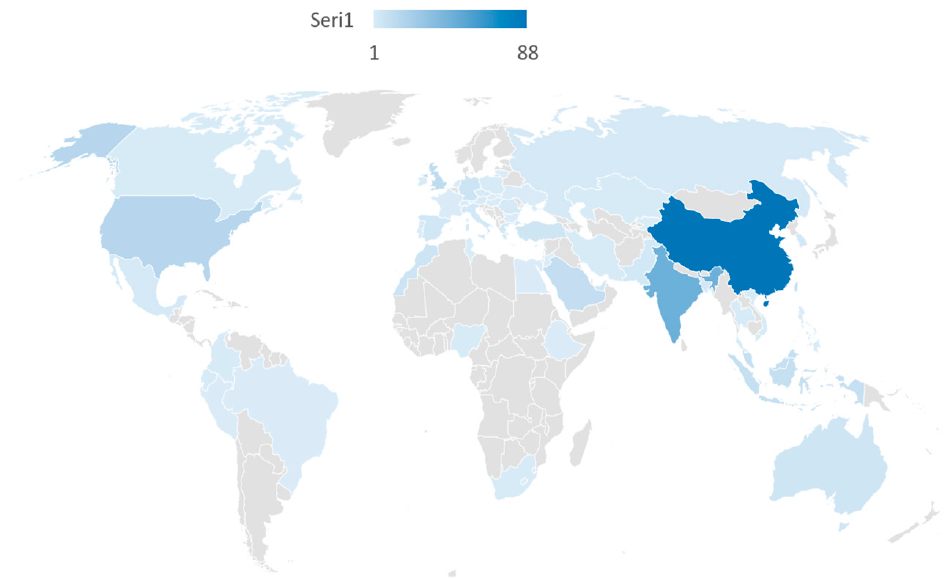
Figure 2. Geographical distribution of AI in online distance education publications.